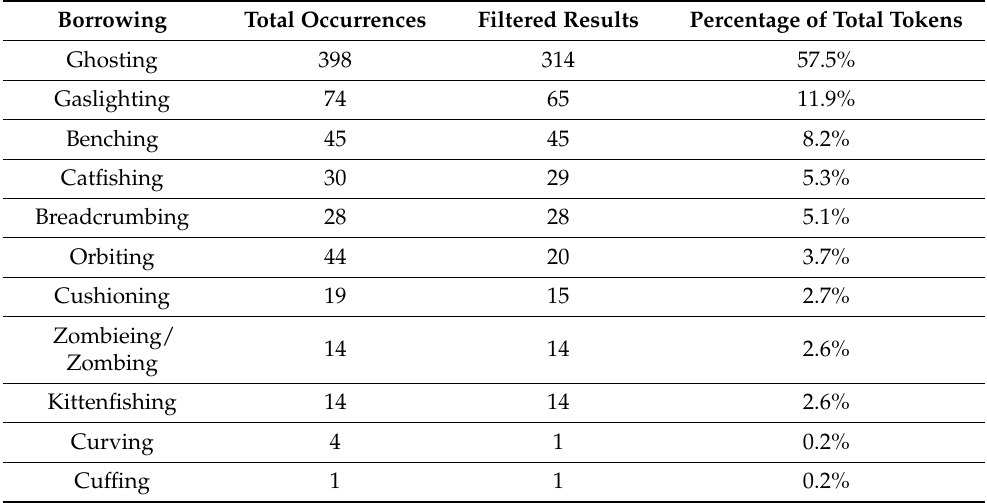
Table 1. Classification of the borrowings that occur in the corpus in order from the highest to lowest